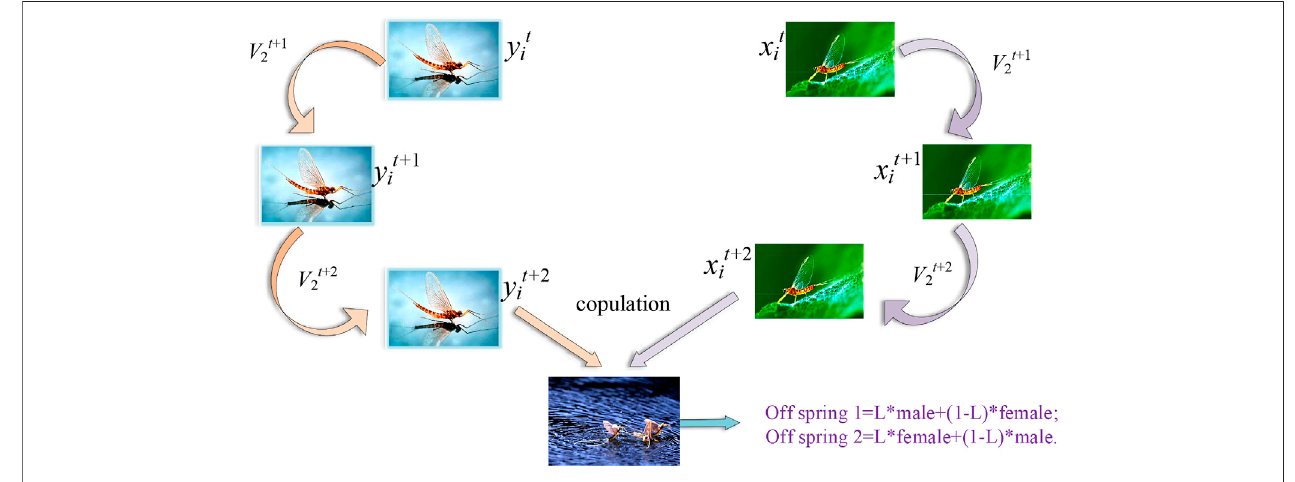
FIGURE 3 | Optimization principle of